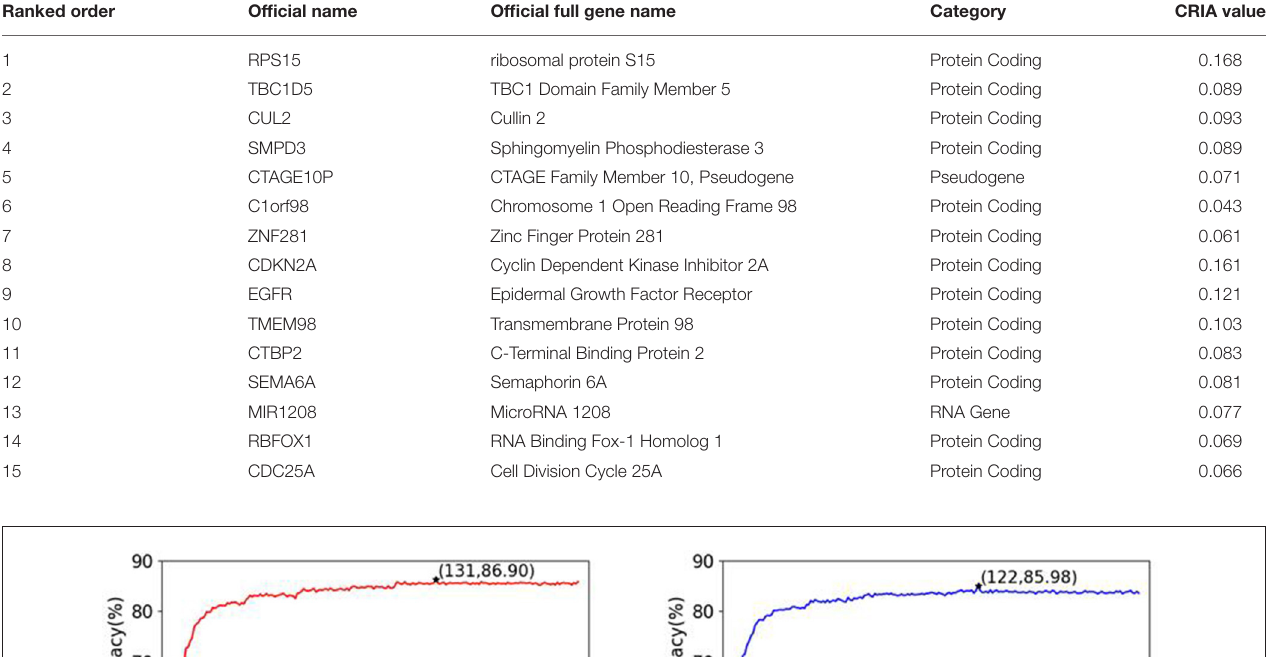
TABLE 6 | The top 15 feature genes chosen by CRIA defined as equation (26). Ranked order